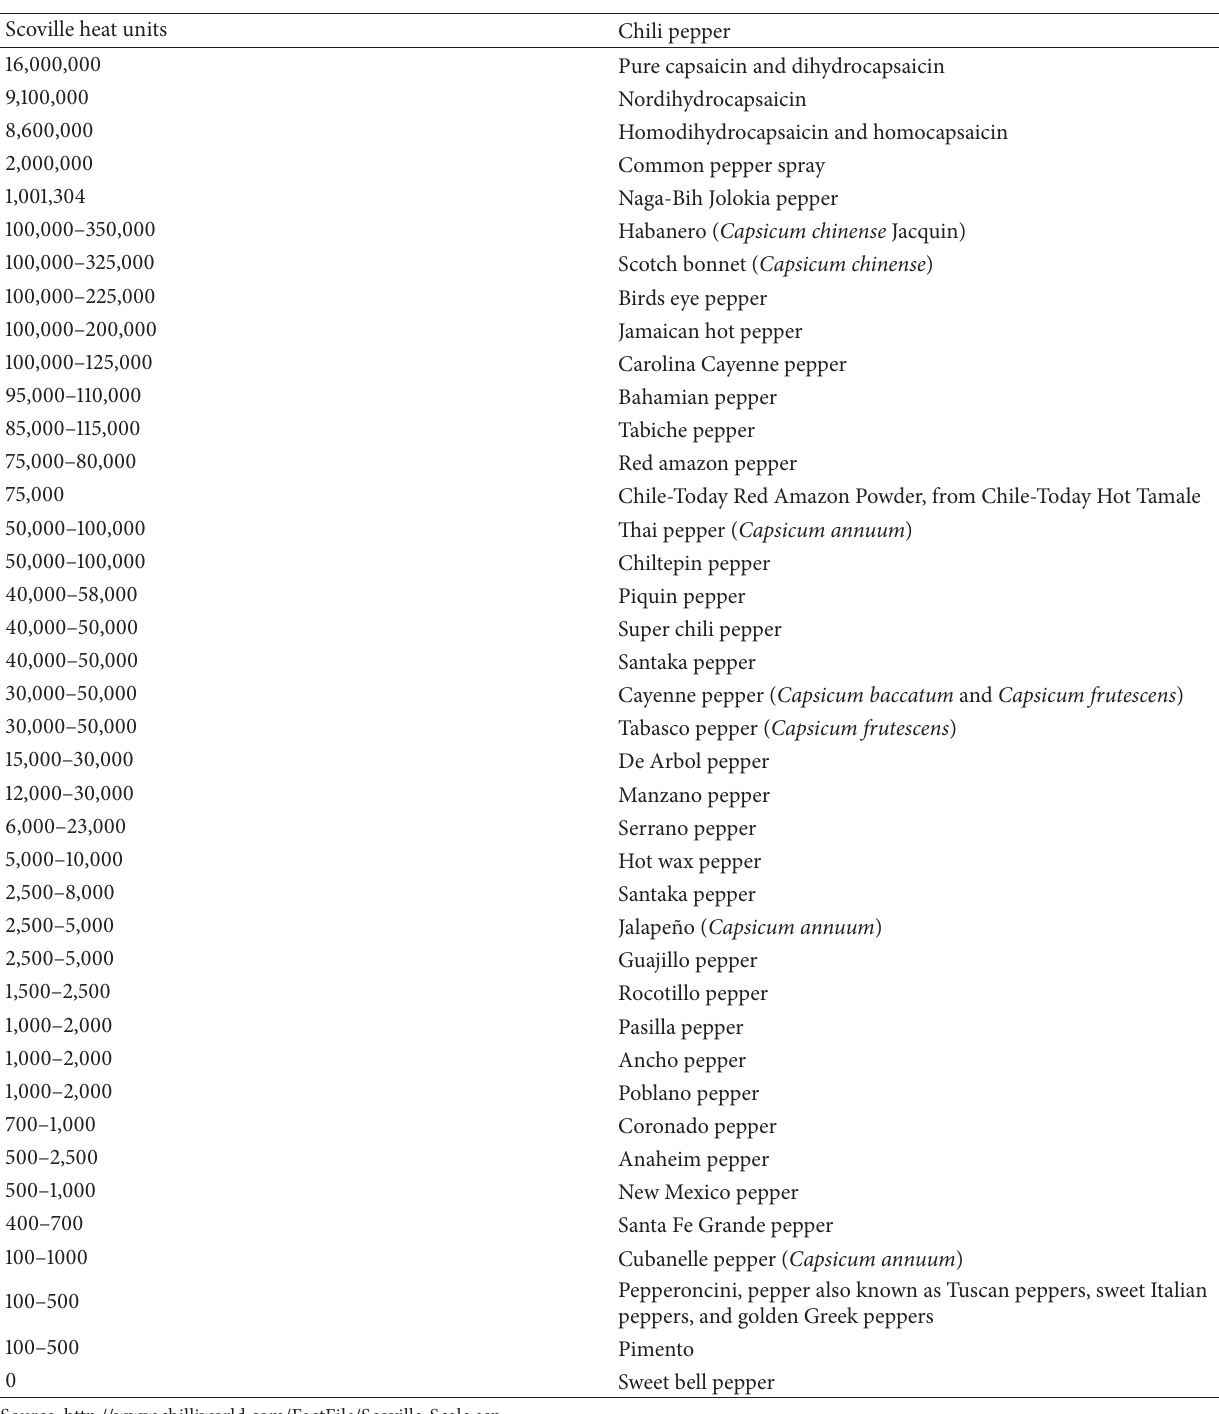
Table 1: Scoville heat units of different chili